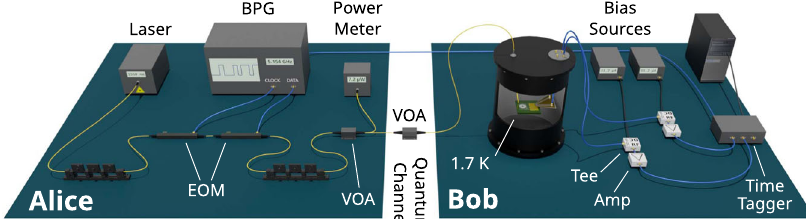
Fig. 3 Measurement setup. Simpli fi ed measurement setup for demonstrating a QKD experiment with the receiver chip. A pseudo-random bit pattern is generated on Alice ’ s side with a CW laser and two electro-optic modulators (EOMs) driven by the bit-pattern generator (BPG). The signal is then attenuated and sent to Bob. The quantum channel is simulated by an additional variable optical attenuator (VOA). The receiver chip is hosted in a cryostat at a base temperature of 1.7 K. The electrical signal from the integrated nanowire detectors is ampli fi ed and then recorded with a time tagger. The post-processing is performed on a PC.